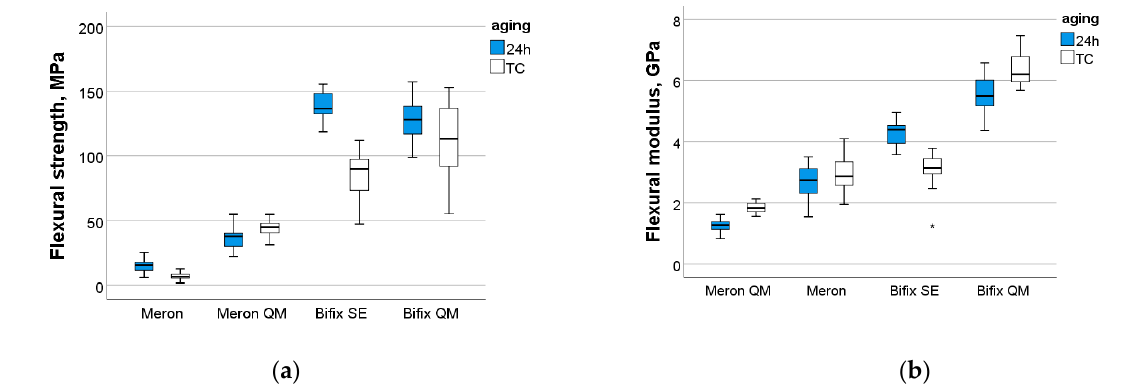
Figure 1. Flexural strength ( a ) and modulus ( b ) as a function of luting material and aging conditions.